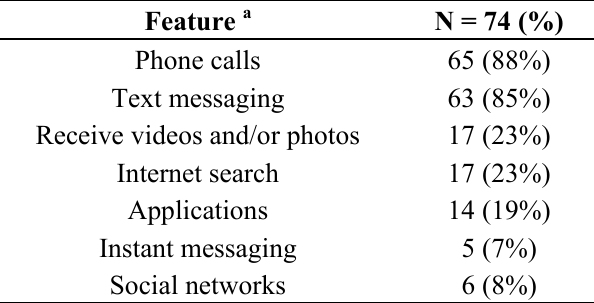
Table 3. Mobile phone features used.